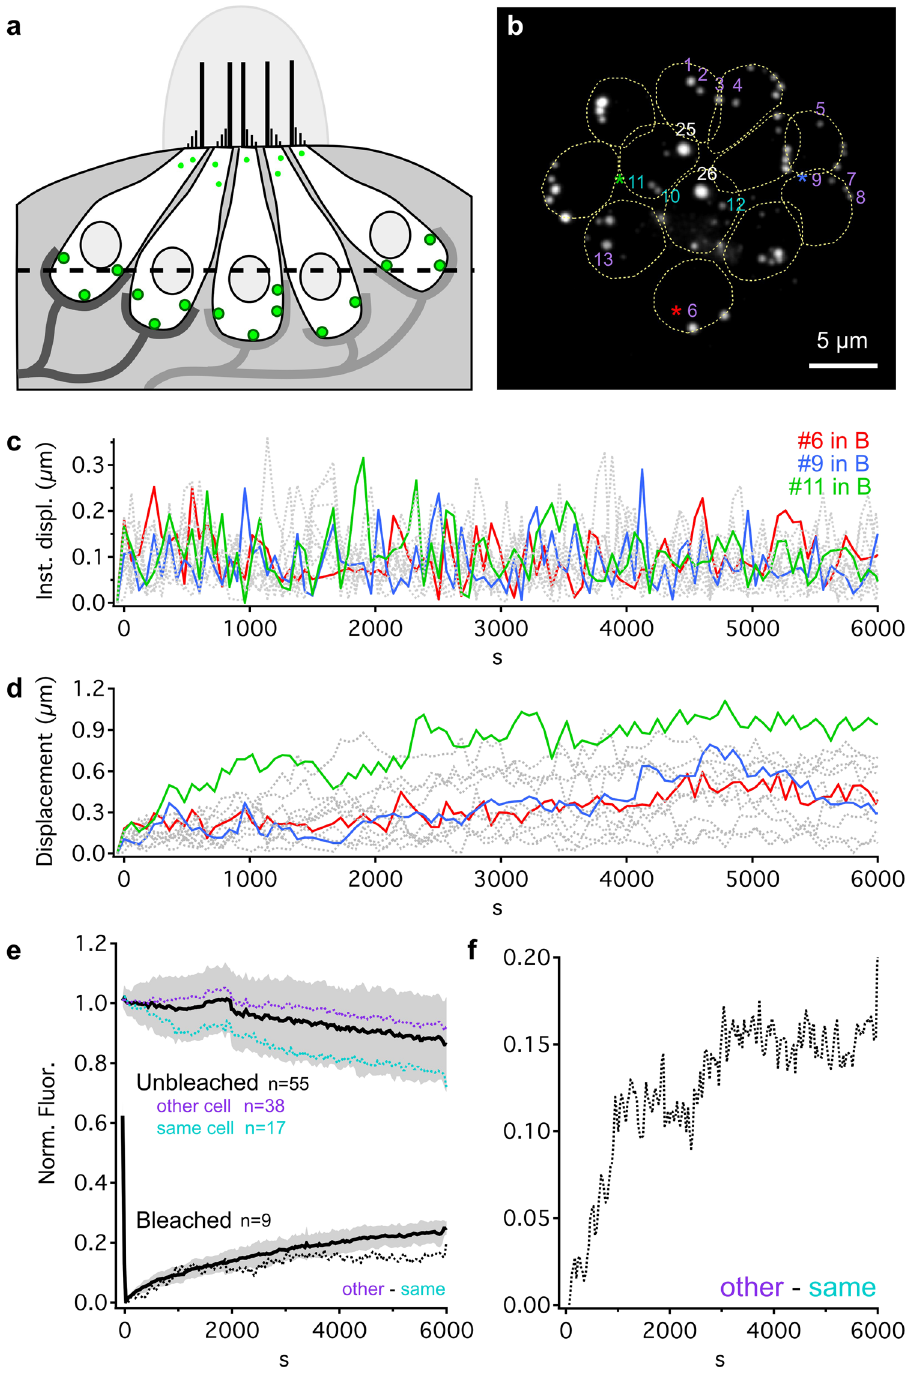
Figure 1. Long term tracking of ribbon movements, Ribeye turnover and exchange. ( a ) Schematic cross-section of a Ribeye b-EGFP neuromast, showing five hair cells contacted by nerve fibers at ribbon synapses (green). Some small Ribeye aggregates accumulate at the apical surface of the hair cells - these were excluded from analysis. The dotted line corresponds to the imaging plane shown in b. ( b ) Example maximum intensity projection of a whole Ribeye b-EGFP neuromast (top-down view). Numbers indicate specific ribbons, spread across the neuromast, used for analysis in c–f . Dotted: cell outlines. Colors correspond to c–f . Ribbons “25” and “26” were bleached (white). ( c) Instantaneous displacements calculated for movements made between image acquisitions (~1 min interval) for the length of our experiments. Red, blue, and green traces correspond to ribbons (labeled with * ) in b . Other labeled ribbons in b are dashed gray. ( d ) Same ribbons as c, showing accumulated X-Y displacements through time. ( e ) Normalized average fluorescence intensity through time following bleaching of whole ribbons (bold black ± SD in gray). Unbleached ribbons were sorted as either 1) in the same cell as a bleached ribbon (teal) or, 2) in a cell with no bleached ribbons (purple). Dashed black line: difference between “same cell” and “other cell” lines. ( f ) Zoomed view of difference between “same cell” and “other cell” lines from e . See also Supplementary Fig.